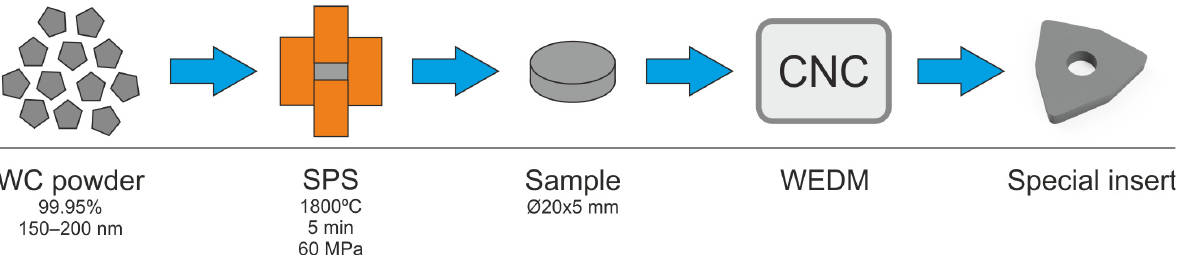
Figure 3. Schematic diagram of the special insert’s process preparation.